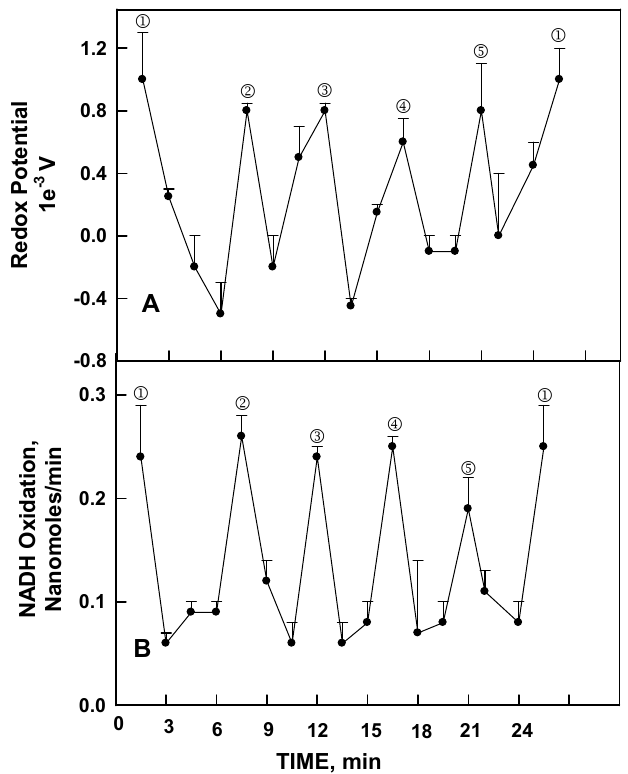
Figure 3. Averages of 3 (A) or 4 (B) decomposition fits [11] ± standard deviations for changes in redox potential ( A ) and rate of NADH oxidation measured as for Figure 2A ( B ) for 10 (A) or 25 (B) mM solutions of Cu II Cl 2 each with a period length of 24 min.